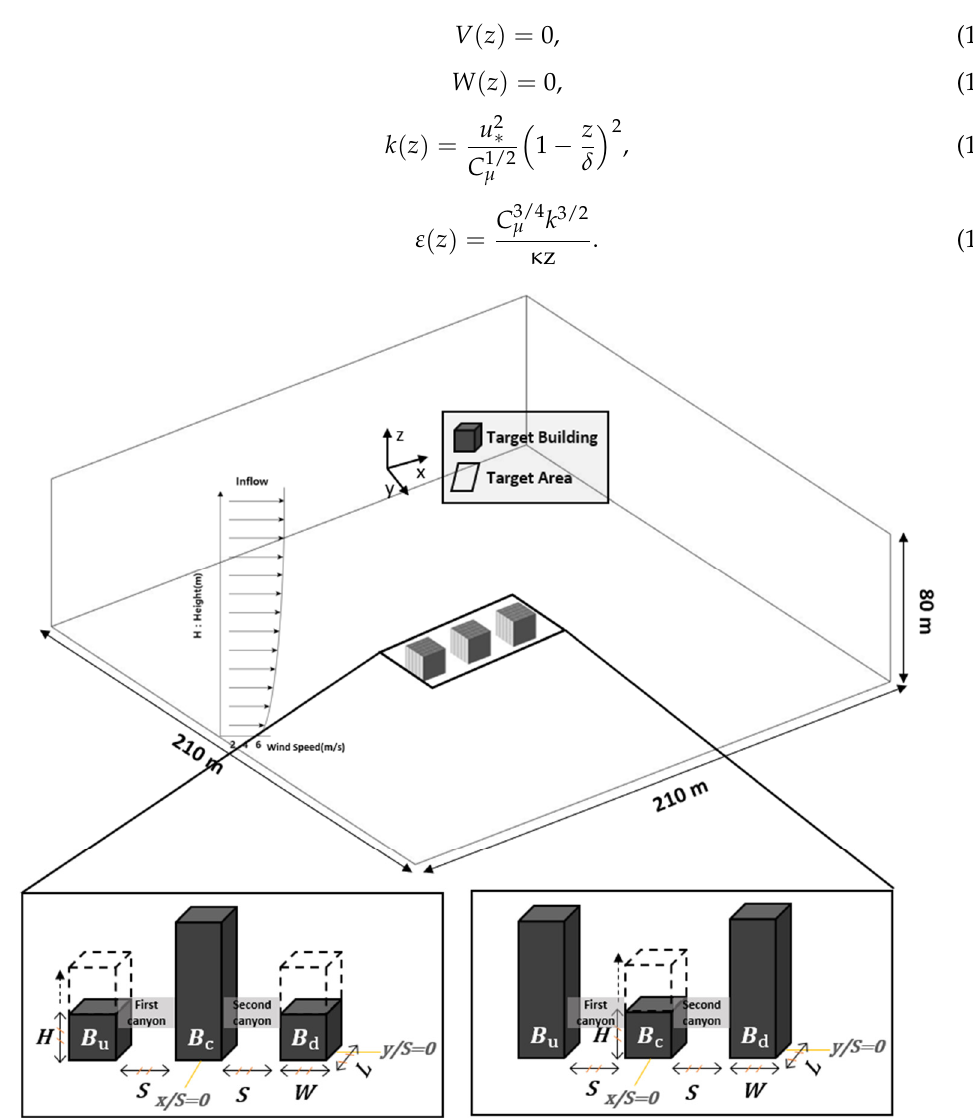
Figure 2. Computational domain and buildings configuration.